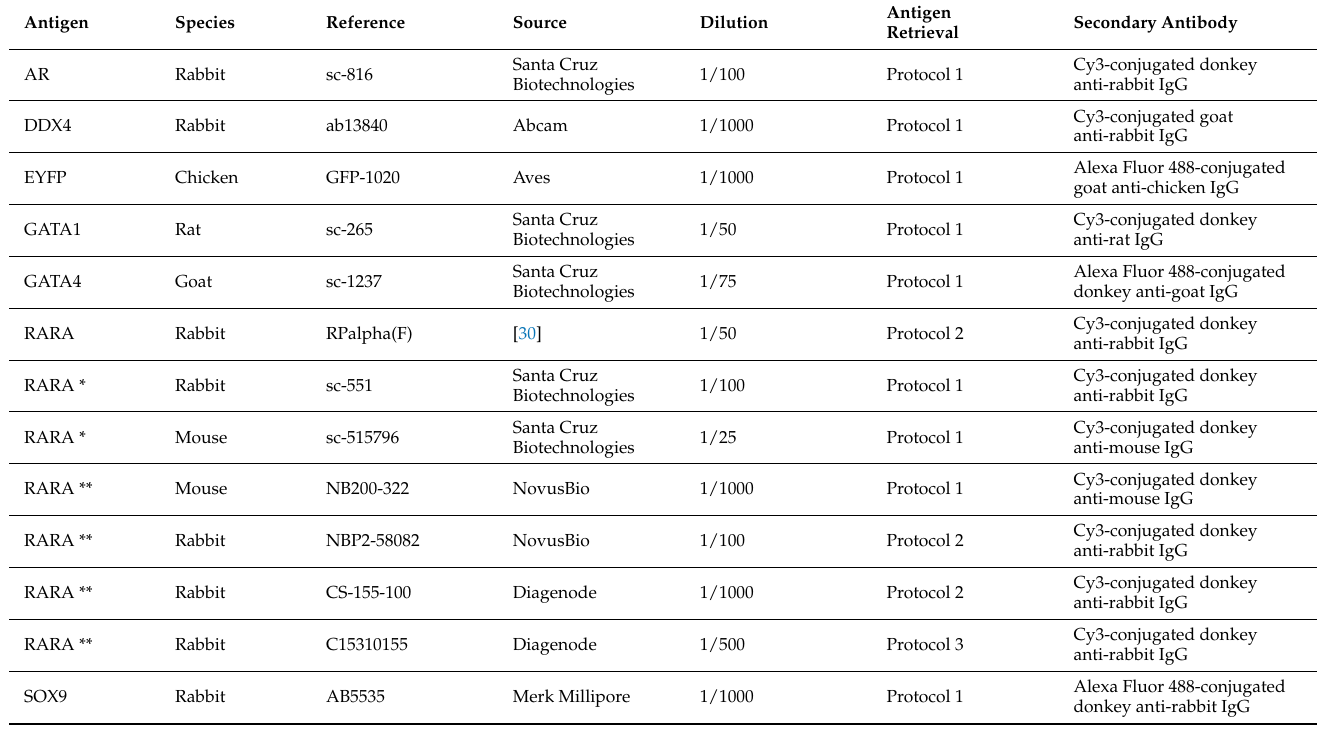
Table 2. List of antibodies used in the present